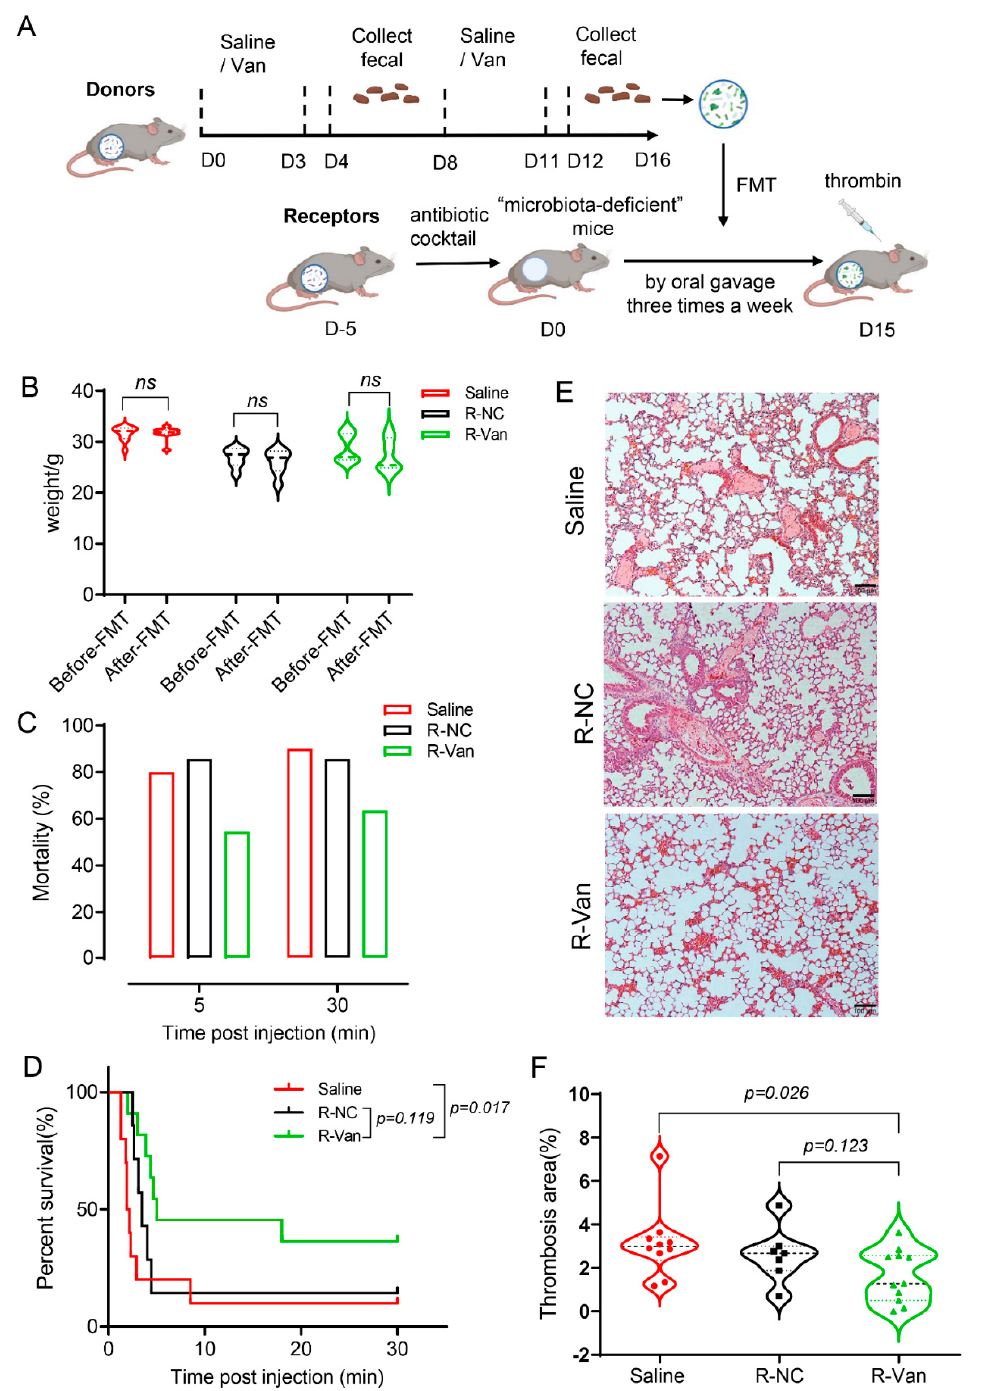
Figure 5. Transfer of vancomycin—improved gut microbiota to mice via FMT inhibits PE. ( A ) Experimental design of FMT: saline—treated mice and vancomycin-treated mice were used as donors to provide gut microbial. The AVMN—treated mice were receptors. ( B ) Weight of mice before and after FMT. ( C ) Number (percentage, %) of PE mice treated with the FMT and saline dead at 5 and 30 min post—thrombin injection. ( D ) Survival rate of APE mice treated with the FMT, and saline was recorded during a 30—minute observation period. The effect of FMT on survival was significant by log—rank test. R—Van vs. Saline, p = 0.0173; R—Van vs. R—NC, p = 0.119; p = 0.003. ( E ) H&E staining of lung sections from mice PE mice treated with the FMT and saline. Scale bar: 100 μ m. ( F ) Quantitative analysis of the thrombus area in panel. These results represent the mean ± sem. Unpaired t test. Saline group, n = 10; R—NC group, n = 7; R—Van group, n = 11.